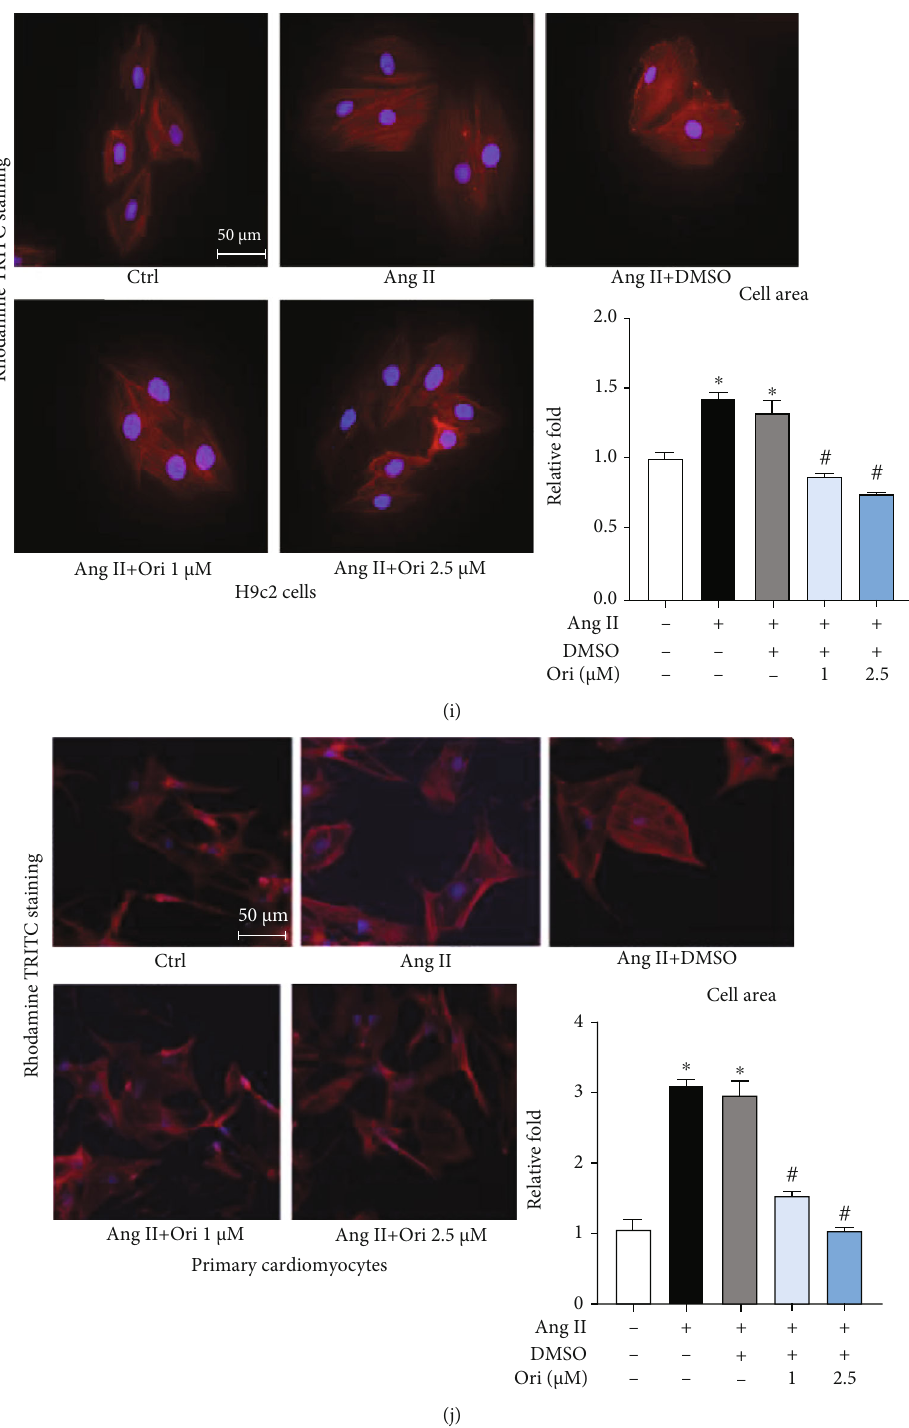
Figure 1: Oridonin can alleviate Ang II-induced myocardial hypertrophy. (a) Structural formula of oridonin. (b, c) The e ff ect on cell viability after incubation of di ff erent concentrations of oridonin in H9c2 cells and neonatal rat cardiomyocytes. (d, f) Pretreated H9c2 cells and neonatal rat cardiomyocytes with Ori (1 and 2.5 μ M) for 1 h before daylong incubation with 1 μ M Ang II. Lysates were analyzed by western blotting for the expression of proteins associated with hypertrophy, and the corresponding semiquantitative statistical graph is shown. (e) The mRNA level of MyHC standardized by β -actin in H9c2 cells. (g) The mRNA level of MyHC in neonatal rat cardiomyocytes. (h) Analysis of the levels of MyHC in H9c2 cells when treated with Ori only. (i, j) Rhodamine-phalloidin staining to determine changes in cell size. 200x magni fi cation; scalebar = 50 μ m . ∗ p < 0 : 05 compared with control; # p < 0 : 05 compared with Ang